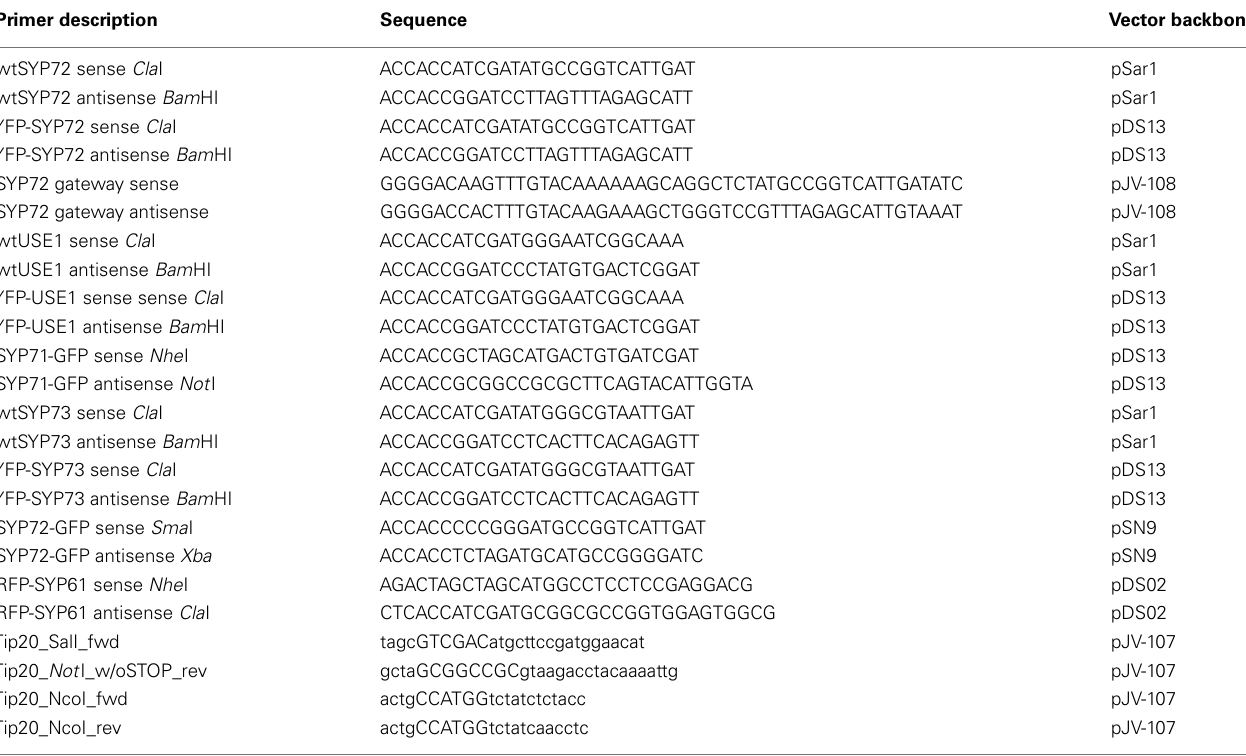
TableA1 | Primers and vectors used in this